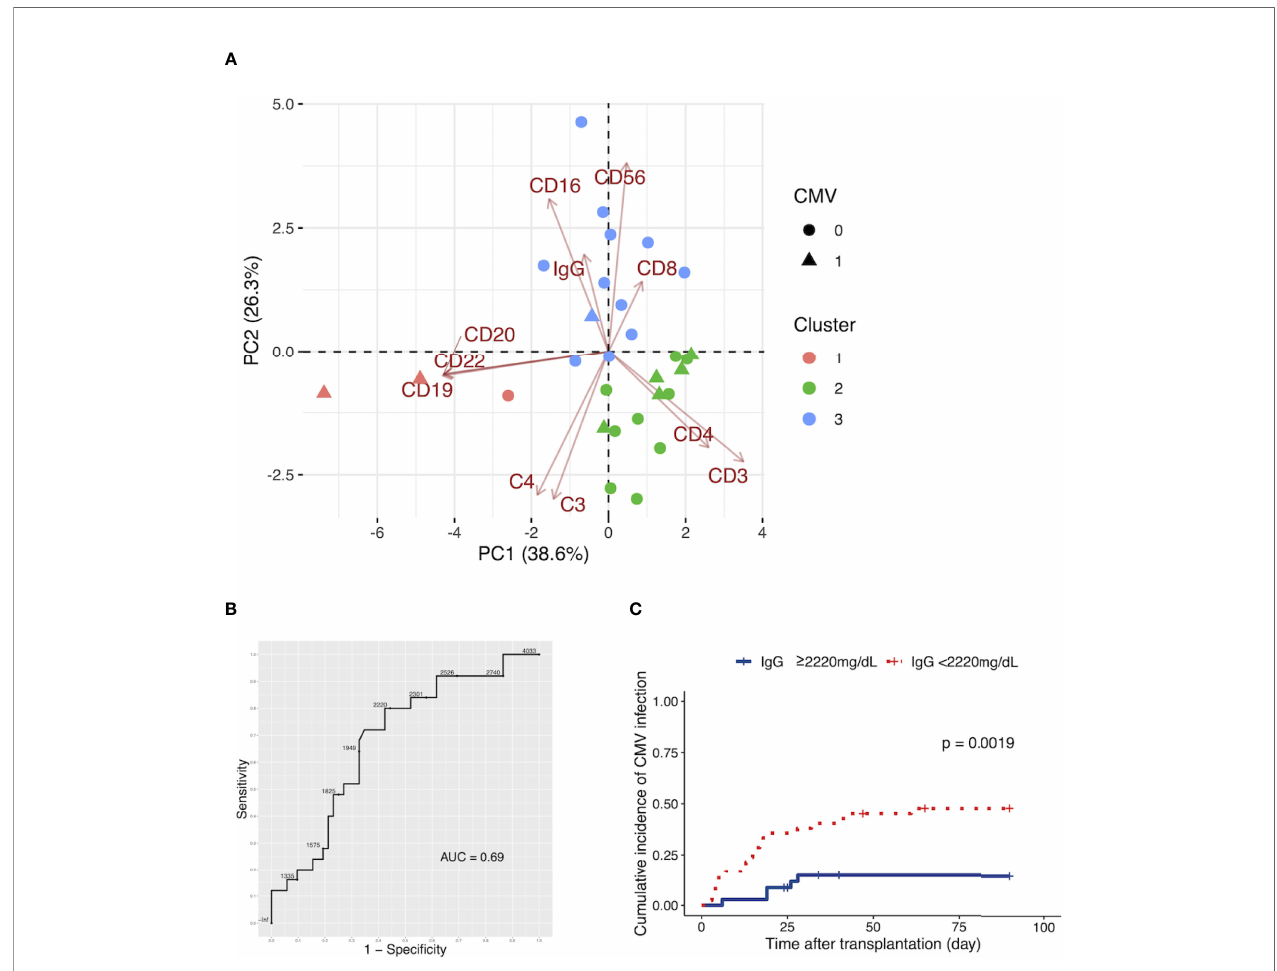
FIGURE 4 | (A) The two-dimensional principal component analysis using the preoperative C3, C4, and IgG levels, and the leukocyte populations. The colors indicate the cluster made by k-means clustering. Circles: patients without cytomegalovirus (CMV) infection by day 90. Triangles: patients with CMV infection by day 90. (B) The ROC curve for the preoperative serum levels of IgG to distinguish patients with CMV infection by day 90 from patients without CMV infection by day 90. (C) The Kaplan-Meier estimates for the incidence of CMV infection by day 90 in patients with a preoperative IgG level of ≥ 2220 mg/dL and patients with a preoperative IgG level of <2220